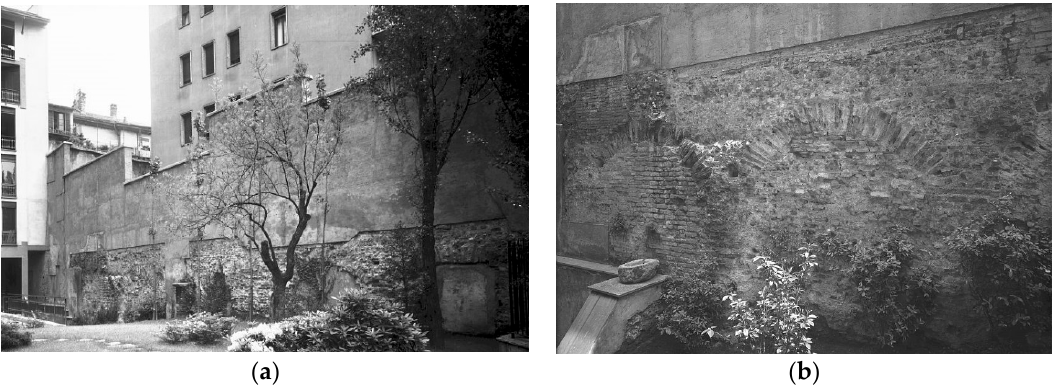
Figure 2. Photographs of the remains of the external wall of the circus visible in a private garden of a building in via Vigna 1: ( a ) the entire portion of the remains; ( b ) a detail of the arches sustaining the podium visible on the wall (courtesy of Ministero dei beni e delle attività culturali e del turismo). podium visible on the wall (courtesy of Ministero dei beni e delle attivit à culturali e del